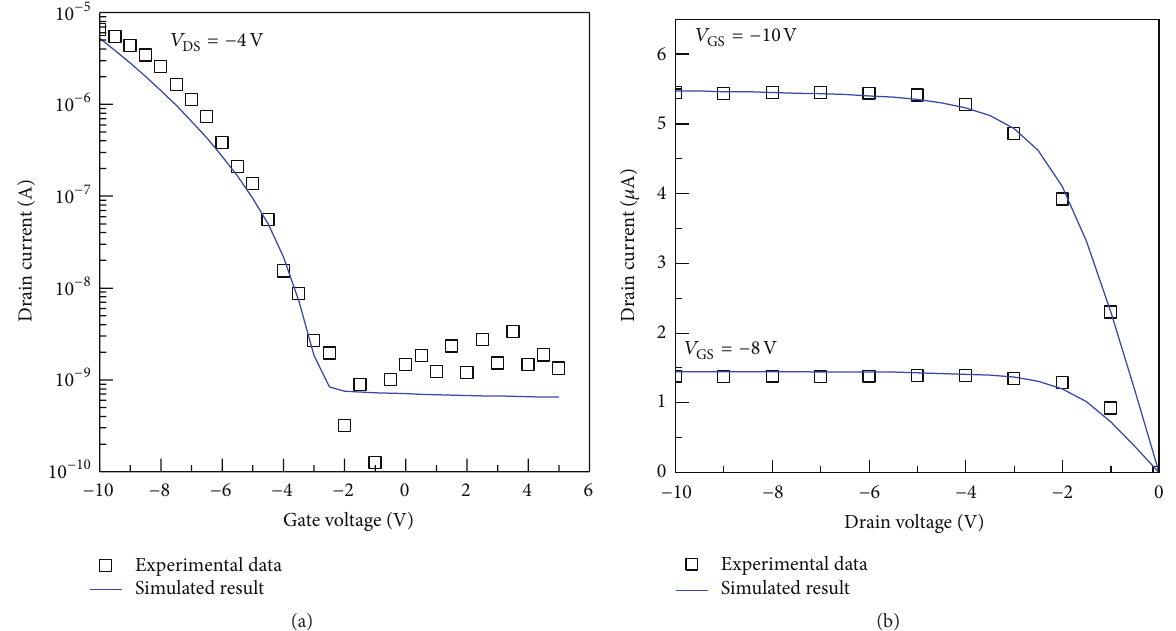
Figure 2: Characteristics of pentacene P-channel obtained from experiment and simulation: (a) transfer and (b) output.